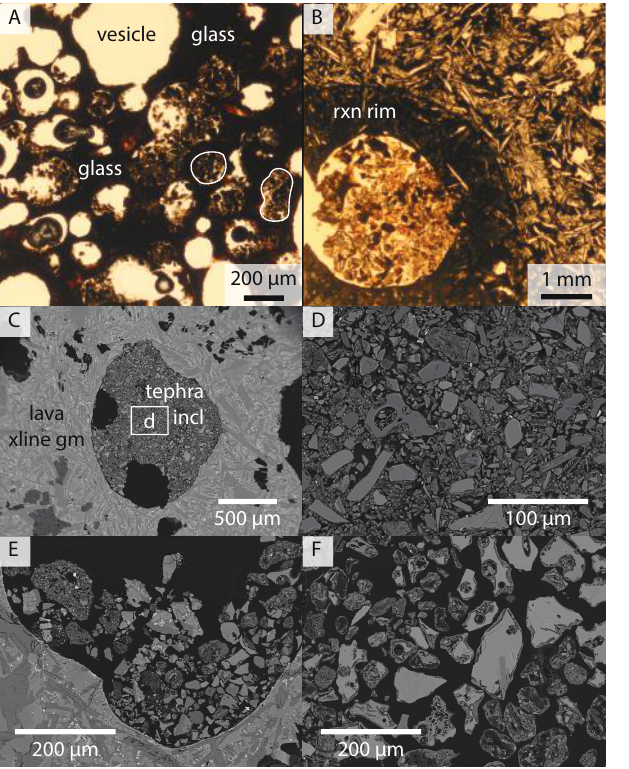
Figure 7: Plane polarize light images of Thríhnúkagígur vent spatter, MC-612-03 [A], and lava, TNG-33 [B] and BSE images of lavas [C–F] show how vesicles are filled with annealed glass shards. ([C–D]: TNG-33; [E]: TNG-35; [F]: TNG-37). The TNG-35 lava sample from Miðhnúkur suggests that entrainment of near surface unconsolidated tephra has occurred multiple times at the Thríhnúkar system through time.